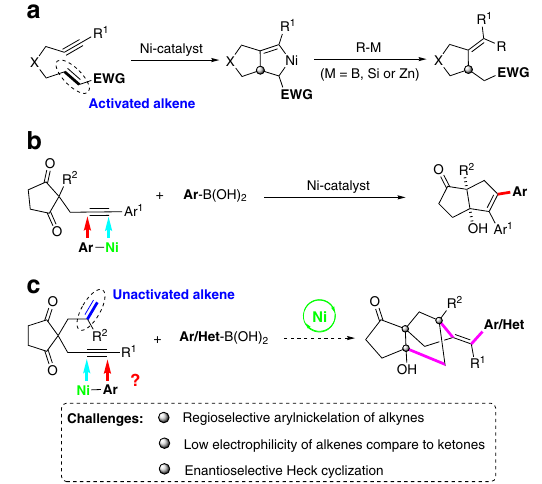
Fig. 2 Reaction design. a Ni-catalyzed coupling cyclization of an alkyne and an activated alkene; b Ni-catalyzed asymmetric coupling cyclization of an alkyne and a ketone; c Working hypothesis for bridged tricyclo[5.2.1.0 1,5 ] decanes synthesis via coupling cyclization of an alkyne, an alkene and a